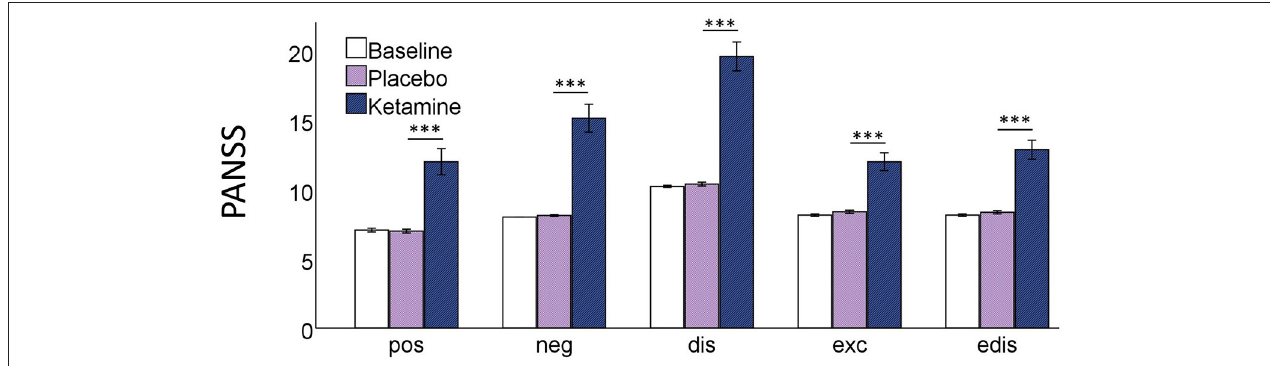
FIGURE 1 | Bar charts of the mean values of the five PANSS subscales; pos positive symptoms, neg negative symptoms, dis disorganisation, exc excitement, edis emotional distress; with error bars representing ± 1 standard errors of the mean (*** p < 0.001).